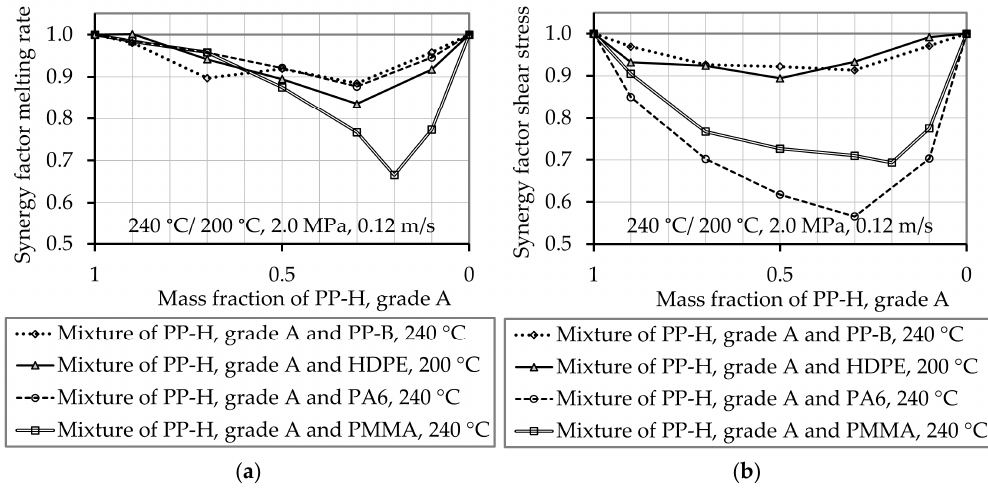
Figure 11. Experimentally determined synergy factors of the melting rate for the mixtures PPH/HDPE, PP-H/PA6, and PP-H/PMMA. PP-H / PA6, and PP-H /